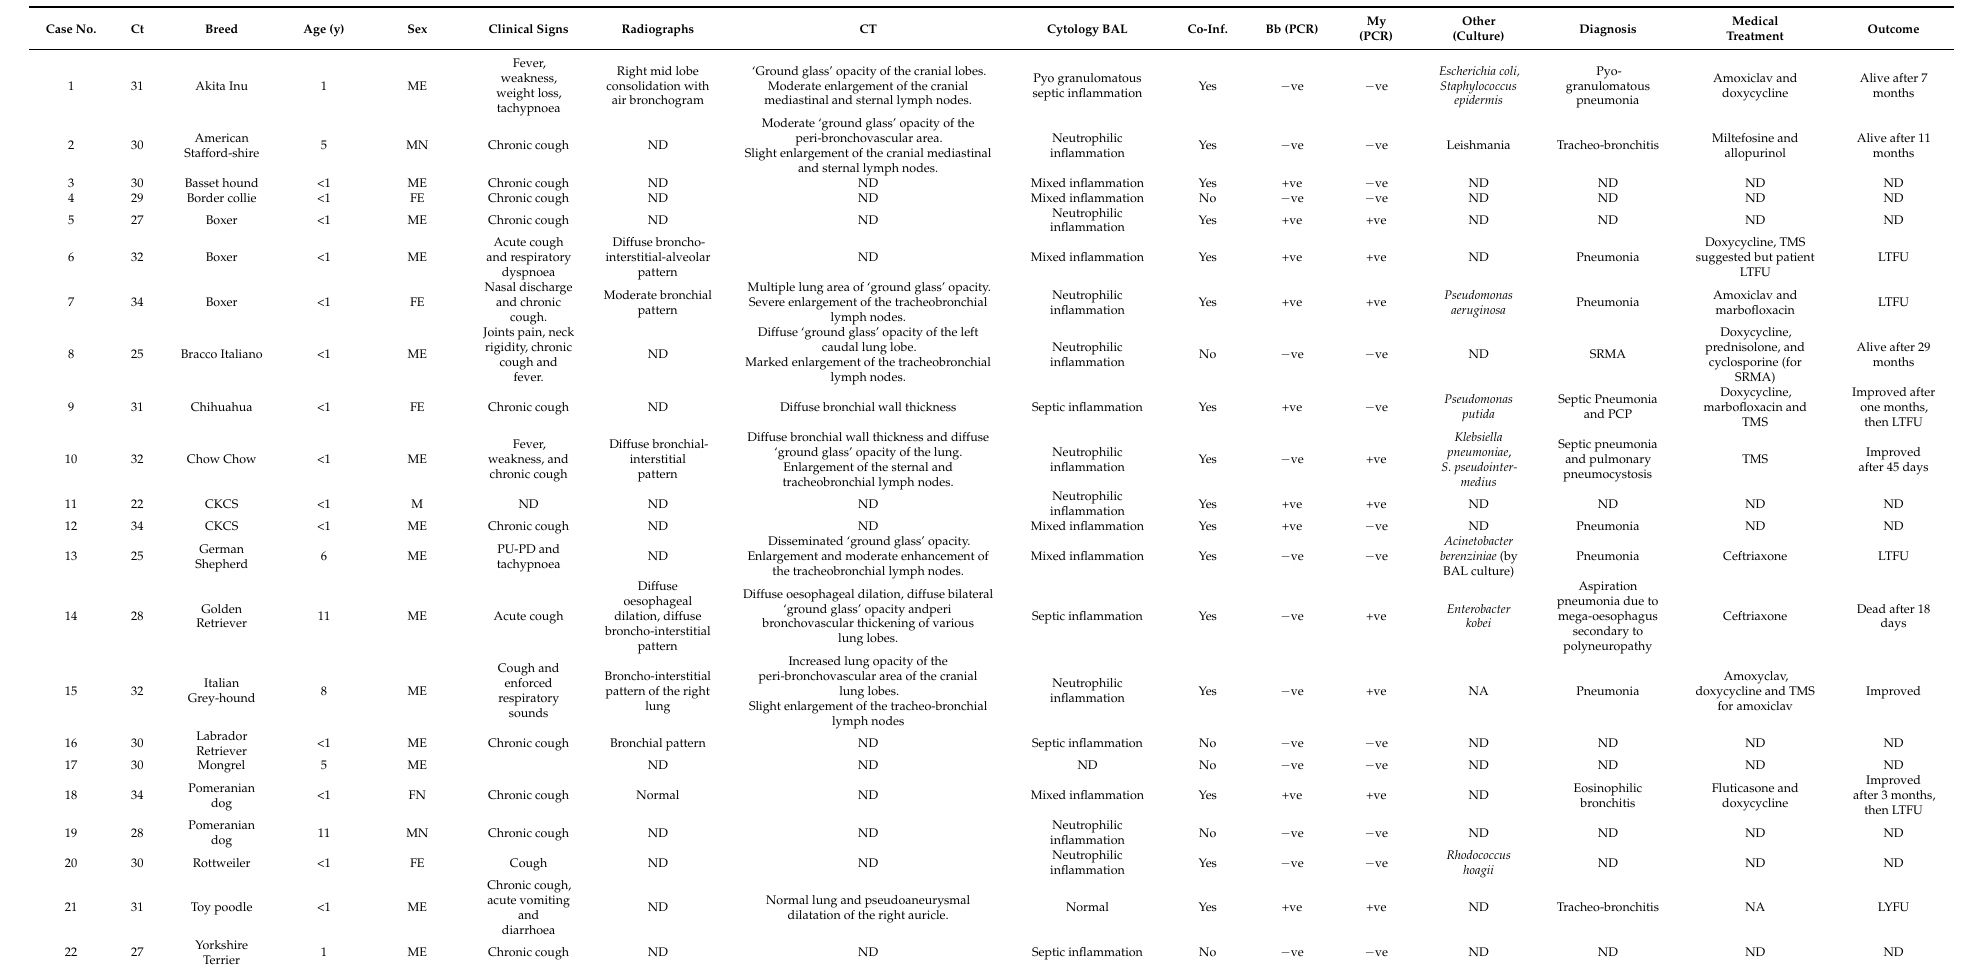
Table 1. Details of Pneumocystis positive dog including breed, gender, age, clinical signs, radiographic and laboratory findings, treatment, and outcome when